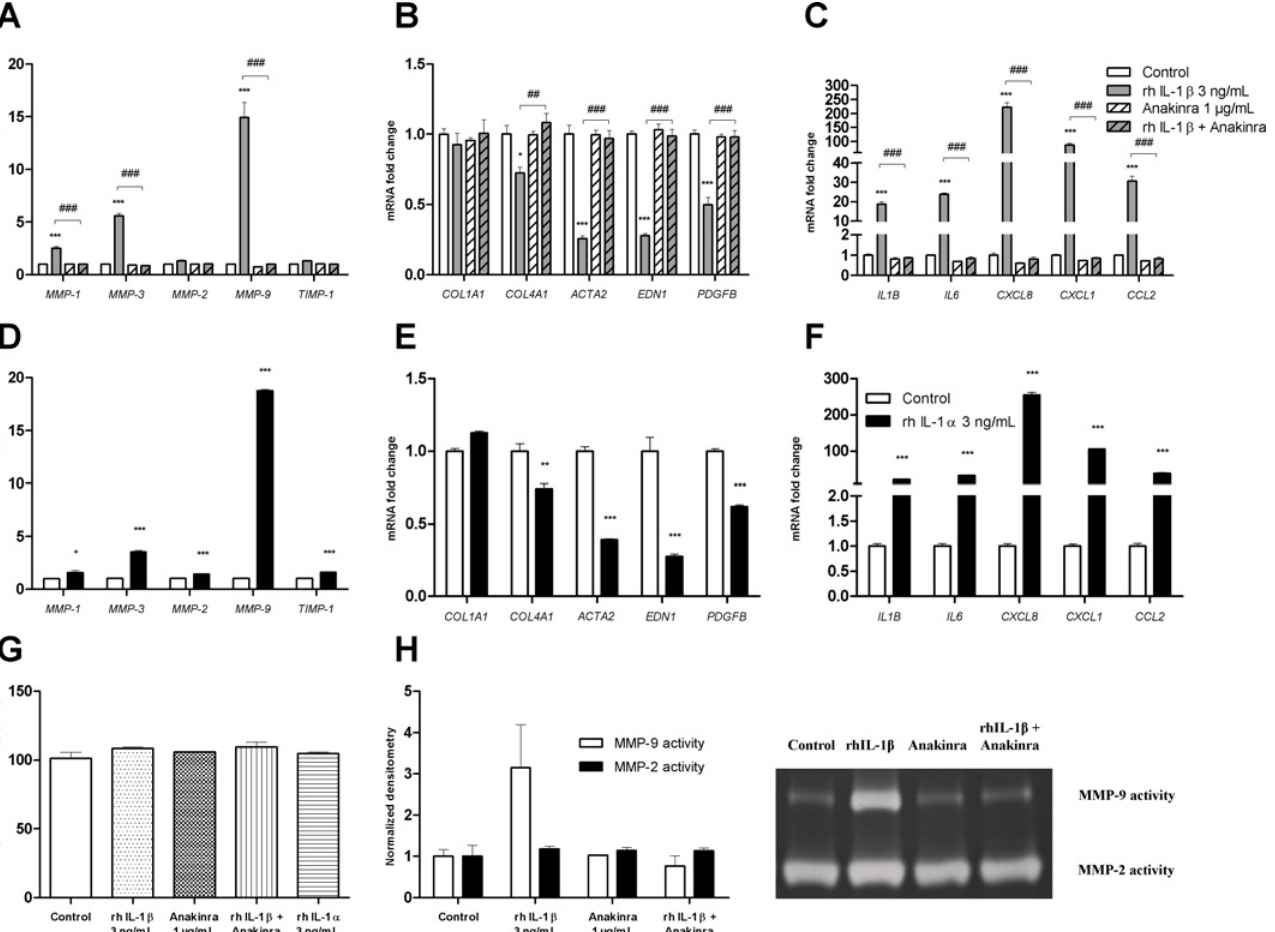
Fig 5. Effects of IL-1 β and IL-1 α treatment on the fibrolysis balance, fibrotic response and inflammatory response in LX-2 cells. The cells were pre- treated (or not) with the IL-1 receptor antagonist anakinra (1 μ g/mL) and then treated with 3 ng/mL rhIL-1 β or 3 ng/mL rhIL-1 α for 24 hours or 48 hours. (A, D) mRNA expression of metalloproteinases (MMP-1, MMP-3, MMP-2, MMP-9) and tissue inhibitor of metalloproteinases (TIMP-1), as measured with real-time PCR and normalized against that of GAPDH after 24 hours of treatment. (B, E) mRNA expression of fibrogenesis factors (COL1A1/collagen I α 1, COL4A1/ collagen IV α 1), myofibroblast differentiation factors (ACTA2/ α -smooth muscle actin) and myofibroblast activation factors (EDN1/endothelin-1, PDGFB/ platelet-derived growth factor-BB), as measured with real-time PCR and normalized against that of GAPDH after 24 hours of treatment. (C, F) mRNA expression of proinflammatory cytokines (IL1B/interleukin-1 β , IL6/interleukin-6) and chemokines (CXCL8/interleukin-8, CXCL1/GRO α , CCL2/MCP1), as measured with real-time PCR and normalized against that of GAPDH after 24 hours of treatment. (G) Pro-collagen I α 1 secretion into the supernatant by LX-2 cells was detected with an ELISA after 48 hours of treatment. (H) Gelatinase activities of MMP-9 and MMP-2 released by LX-2 cells into the supernatant after 48 hours of treatment were evaluated by zymography and normalized densitometry. The results are expressed as the mean ± SEM of three independent experiments. * p < 0.05, ** p < 0.01, *** p < 0.001, relative to a control. # p < 0.05, ### p < 0.001, relative to IL-1 β .